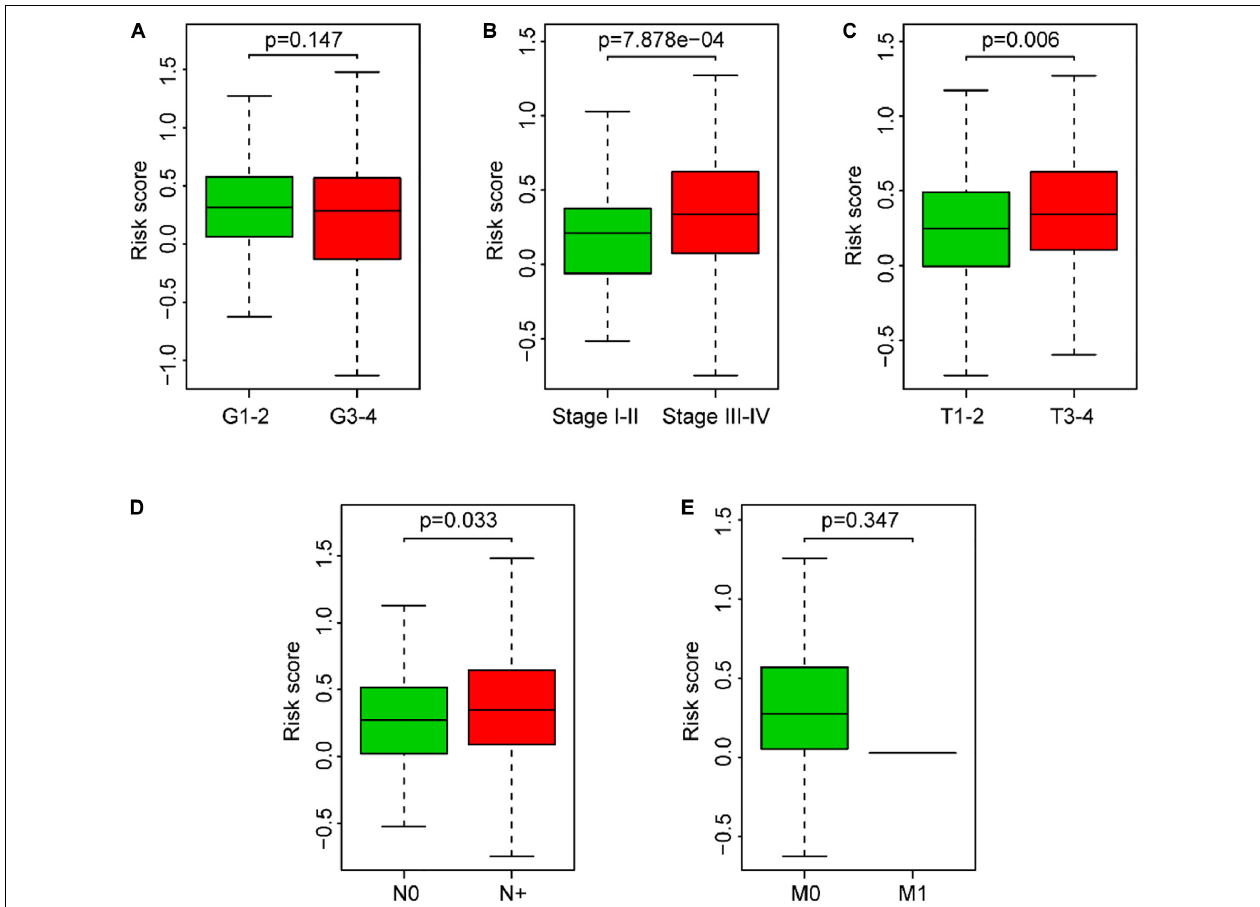
FIGURE 7 | Association between the risk score and clinical characteristics of SCCHN patients. (A) Subgroup analysis of pathology grade (Grades 1–2 vs. Grades 3–4). (B) Subgroup analysis of clinical stage (Stages I–II vs. Stages III–IV). (C) Subgroup analysis of T classification (T1–2 vs. T3–4). (D) Subgroup analysis of N classification (N0 vs. N+). (E) Subgroup analysis of M classification (M0 vs. M1).